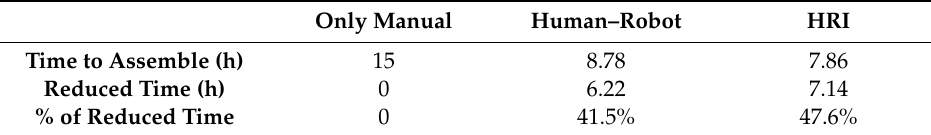
Table 4. Simulation